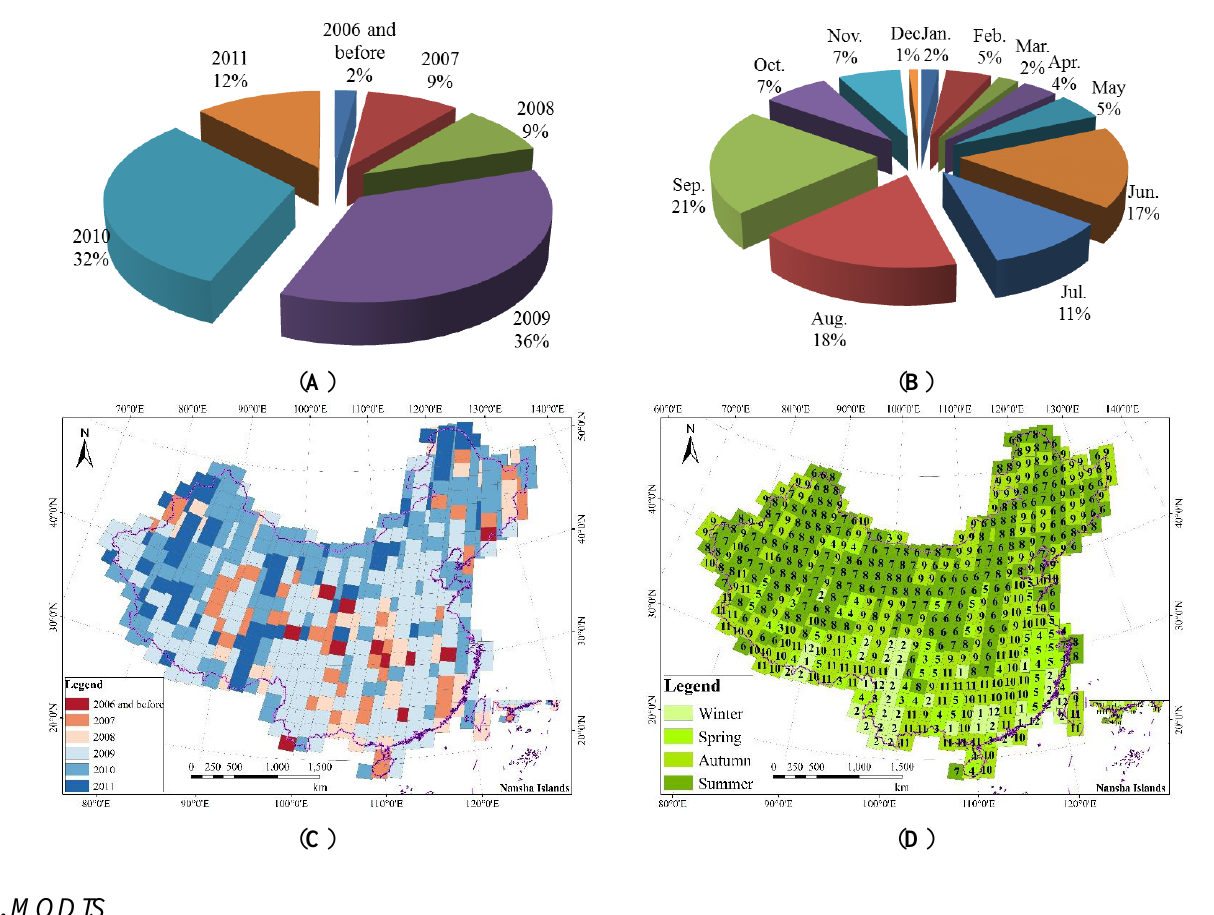
Figure 1. ( A ) Acquisition years of Landsat TM data. ( B ) Acquisition months of Landsat TM data. ( C ) Annual distribution of Landsat TM data. ( D ) Seasonal and monthly distribution of Landsat TM data (the labels are acquisition